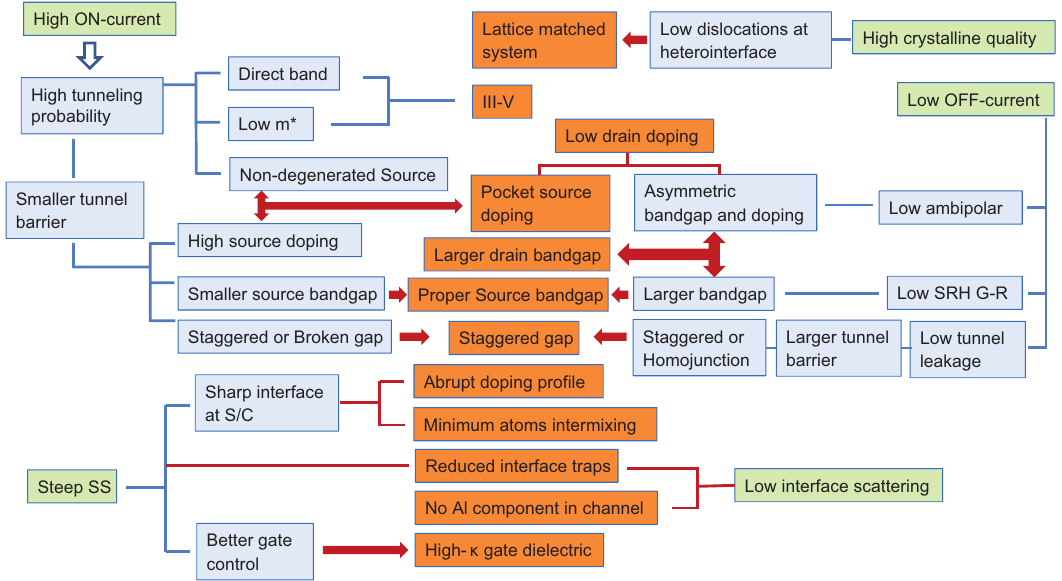
Figure 16. It can be seen from Figure 16 that E decreases beff linearly with increasing In and Sb compositions. This E plays a significant role in the performance of a TFET beff device, which not only determines the ON-state tun- neling rate but also sets the blocking barrier for OFF-state leakage [9, 13]. Mohata et al. [9, 15] studied GaAs Sb / y 1-y In Ga As n-type TFETs with different E by changing x 1-x beff alloy compositions in source and channel materials. The schematic diagram of these TFET layer structures with different alloy compositions is shown in Figure 17A–C, respectively. These three structures were grown by solid source MBE on semi-insulating InP substrates. For the GaAs Sb /In Ga As structure, the active regions 0.5 0.5 0.53 0.47 are lattice matched to the InP substrate; however, both the other two structures (GaAs Sb /In Ga As and 0.4 0.6 0.65 0.35 GaAs Sb /In Ga As) are lattice mismatched to the 0.35 0.65 0.7 0.3 Figure 16 Simulated changing trade (red dashed line) between effective tunneling barrier height ( E The inset demonstrated the band alignment of GaAs without bias. The definition of E neling barrier height decreases linearly with increasing In and Sb compositions. The two squared points are experimentally deter- mined effective tunneling barrier height values, both of which show similar values to the simulated values. The slightly smaller values may due to fixed positive charges at the